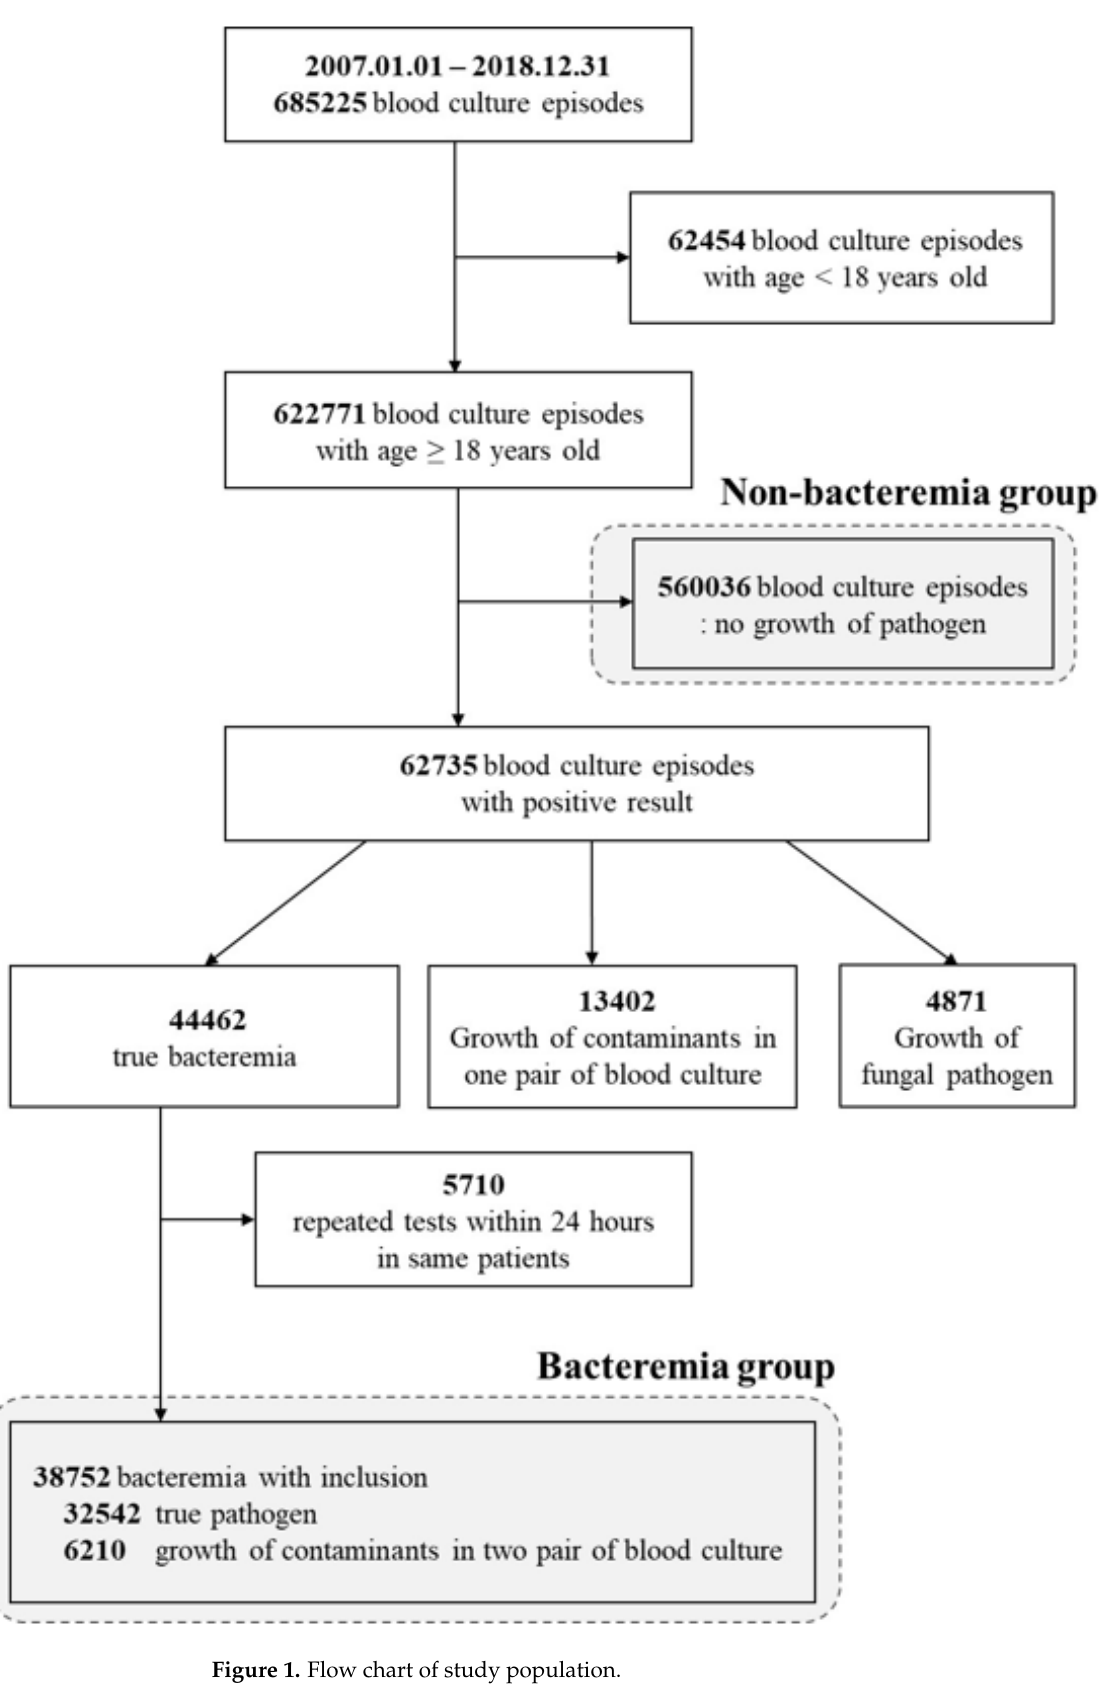
Figure 1. Flow chart of study